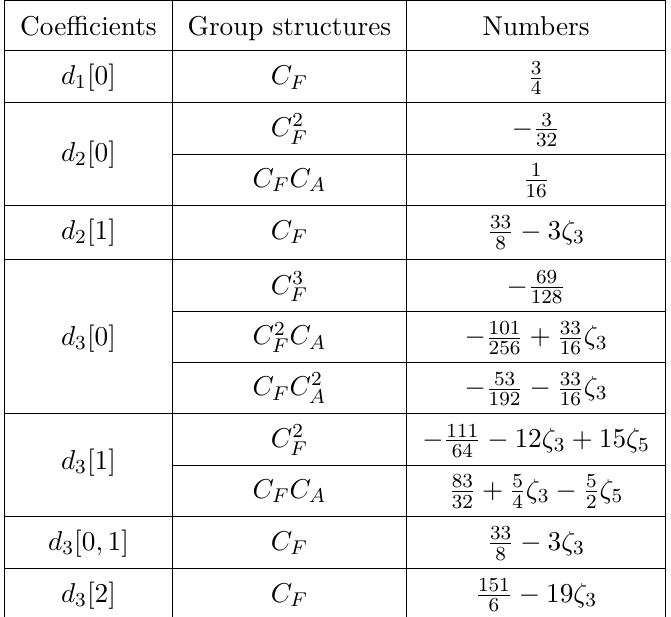
Table 1 . All terms included in the { β } -expansion of coefficients d 1 , d 2 and d 3